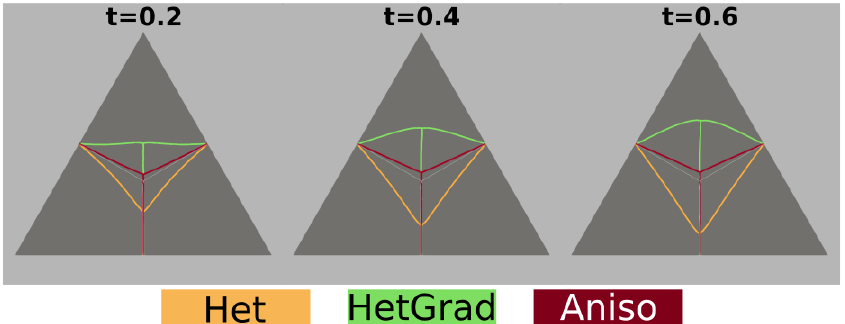
Figure A3. Interface evolution using the Het, Hetgrad, and Aniso formulations of the triple junction with r = 10.